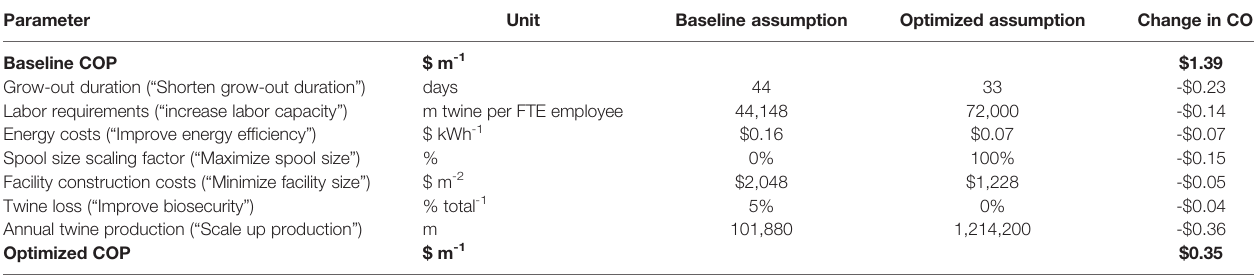
TABLE 4 | Values used in the optimization analysis with ranges derived from semi-structured interviews and literature review. Parameter